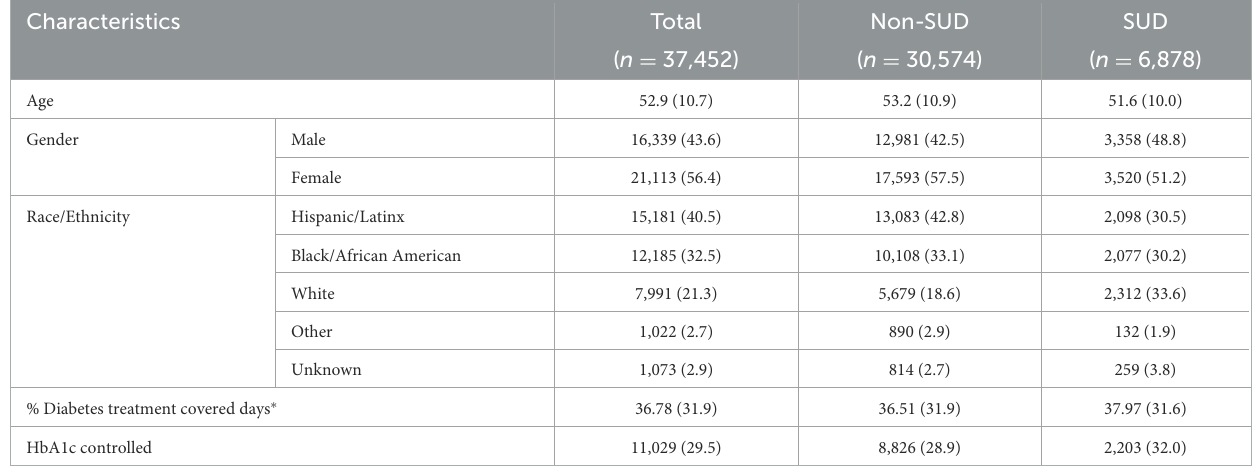
TABLE 1 Baseline characteristics of patients with type 2 diabetes within HCN during